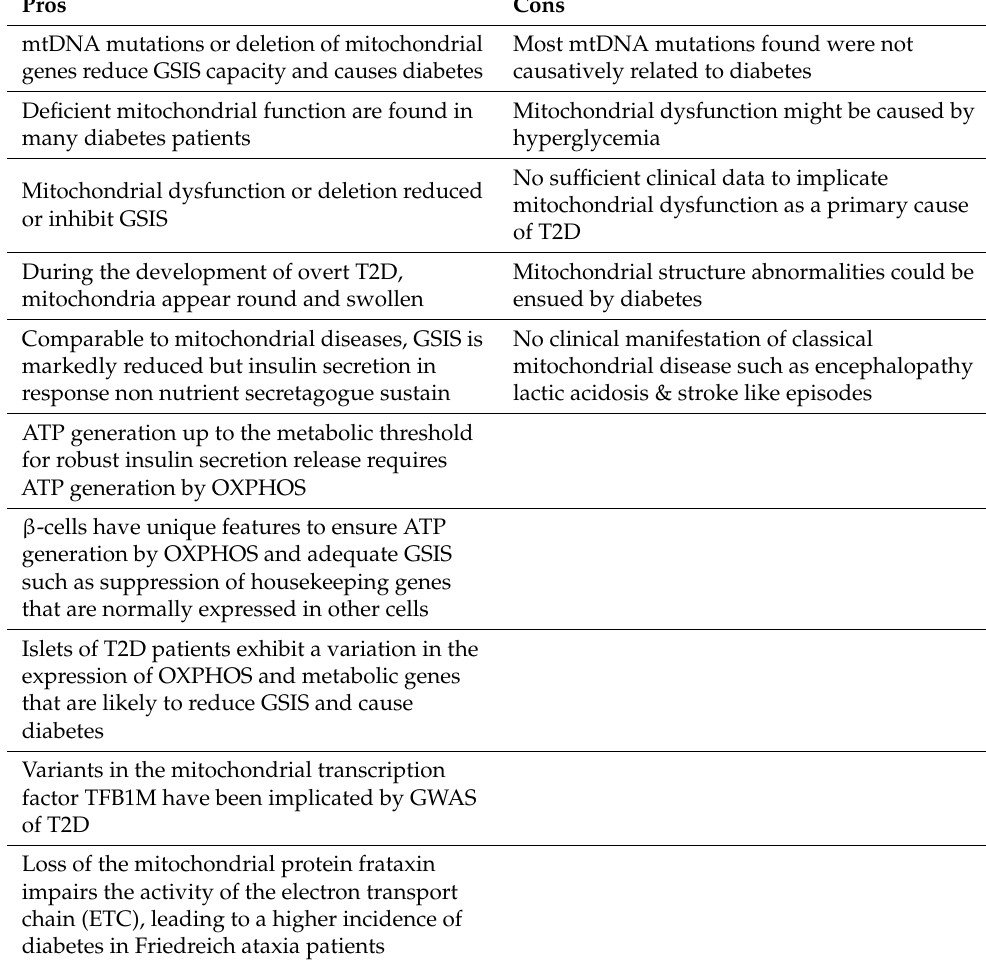
Table 1. T2D as mitochondrial